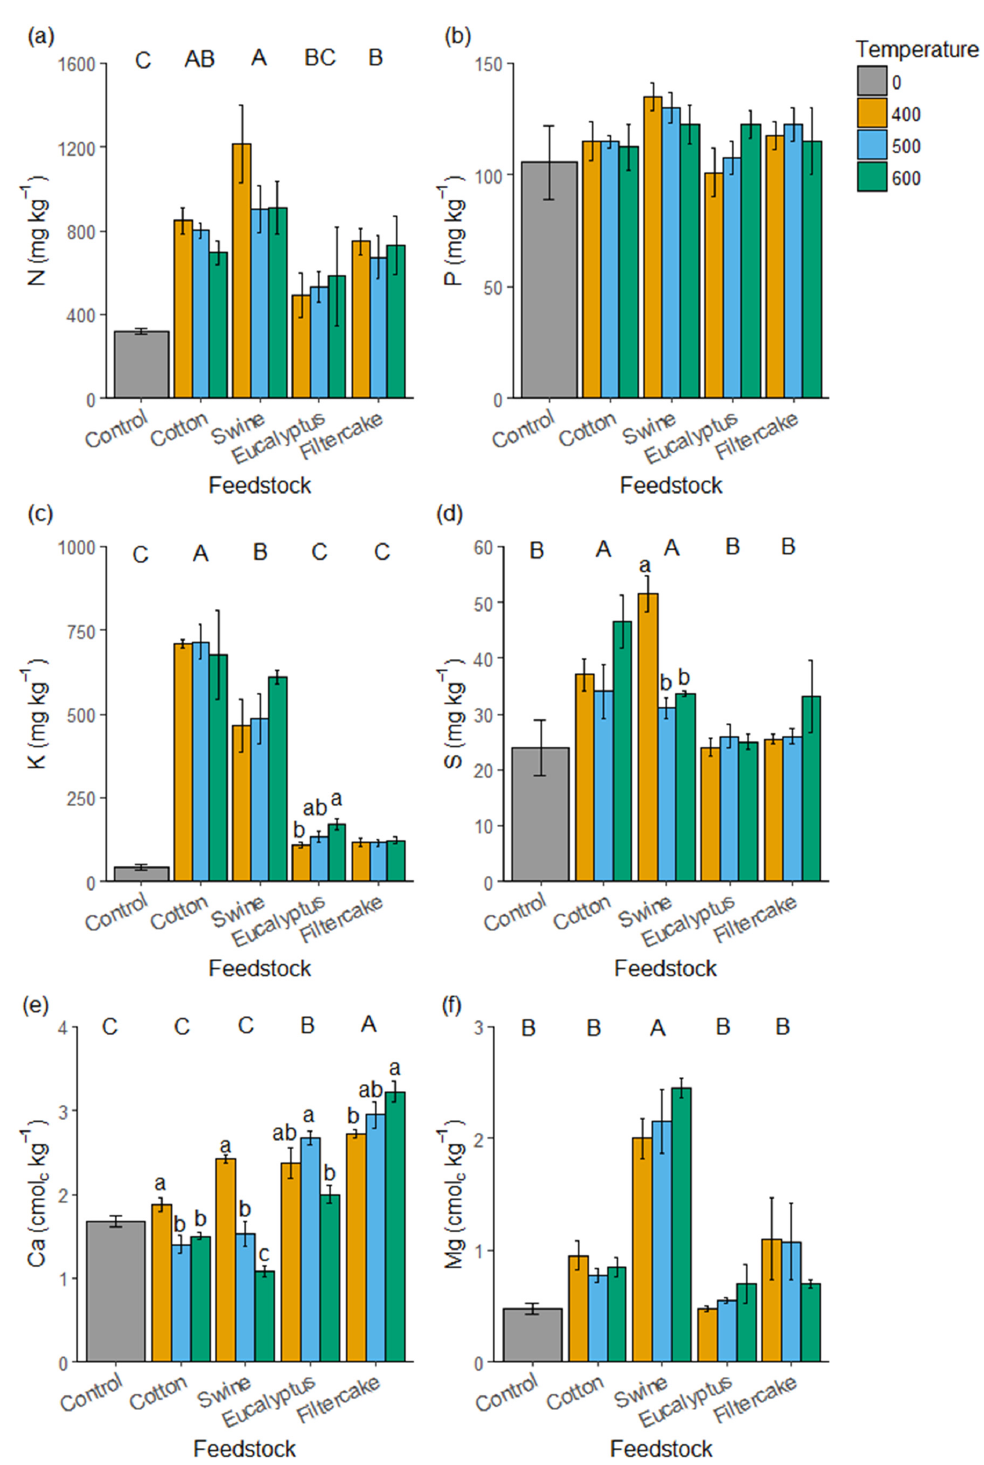
Figure 2. Mean concentration of ( a ) soil total nitrogen (N; mg kg − 1 ) and available soil macronutrients: ( b ) phosphorus (P; mg kg − 1 ); ( c ) potassium (K; mg kg − 1 ); ( d ) sulfur (S; mg kg − 1 ); ( e ) calcium (Ca; cmol c kg − 1 ); and ( f ) magnesium (Mg; cmol c kg − 1 ) in soils with different biochars. Capital letters indicate significant differences between the feedstocks and lowercase letters indicate significant differences between the temperatures for each feedstock (ANOVA, Tukey post-hoc test, p < 0.05); where absent, differences were not